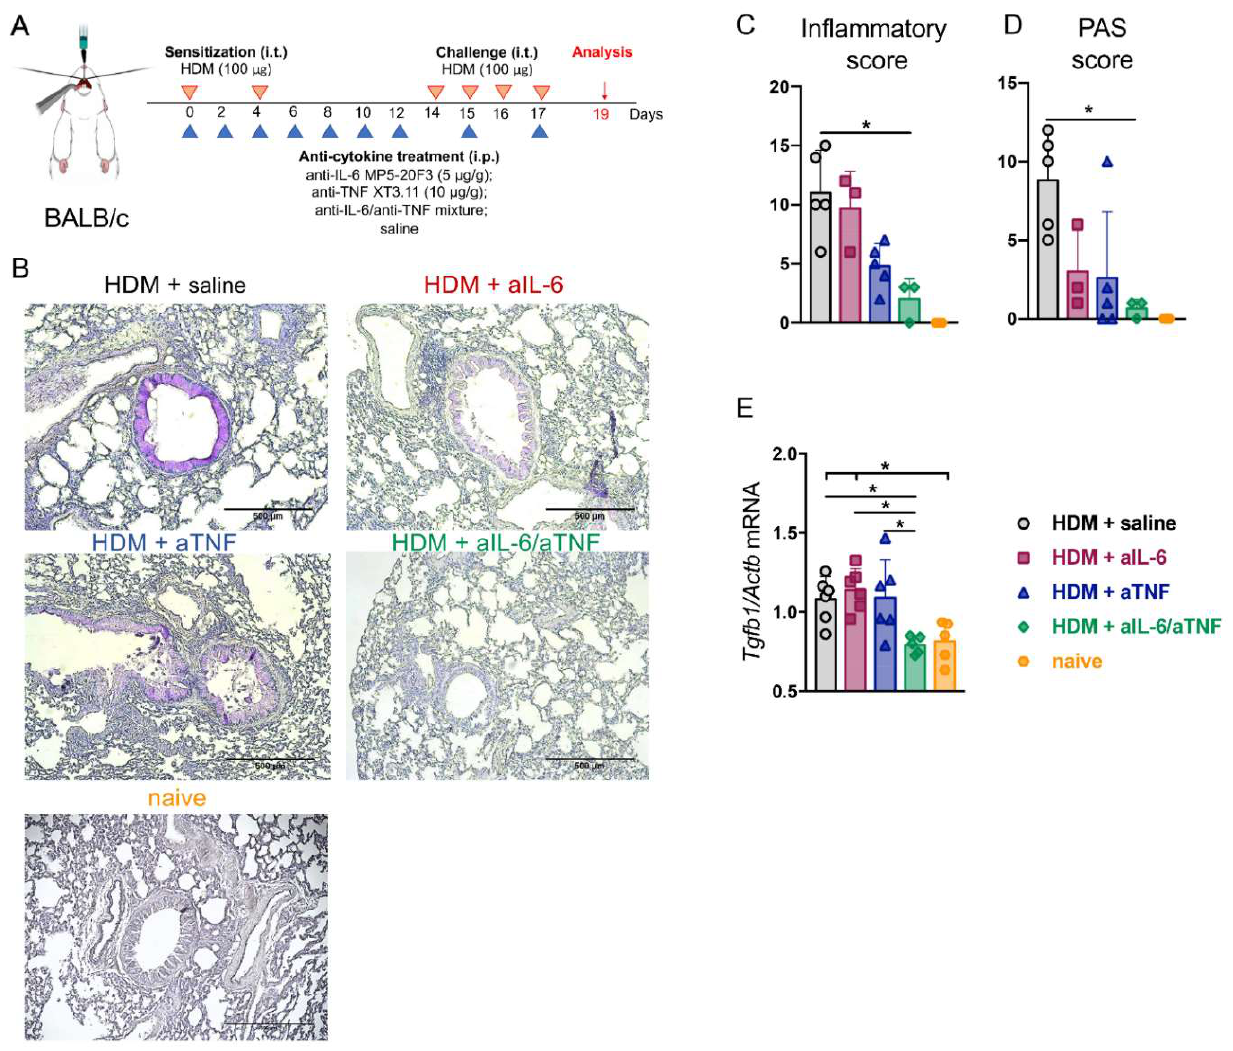
Figure 4. Assessment of lung histology in mice with severe HDM-induced asthma undergoing combined administration of IL-6 and TNF inhibitors. Simultaneous pharmacological inhibition of TNF and IL-6 led to diminished lung tissue remodeling in severe HDM-induced asthma. ( A ) Scheme of severe asthma model; 6–8-week-old BALB/c mice were sensitized i.t. with HDM extract on days 0 and 4 (100 µ g) (red arrows). On days 14–17, mice were challenged i.t. with HDM (100 µ g) (red arrows). Prior to i.t. administration of the allergen, mice were anesthetized by i.p. injection of the Zoletil/Xyla cocktail for anesthesia. Anti-IL-6 (MP5-20F3) (5 µ g/g of body weight), anti-TNF (XT3.11) (10 µ g/g of body weight) antibodies, and saline as a control were administered intraperitoneally prior to each immunization every 48 h for 17 days (blue arrows); 48 h after the last challenge lungs were perfused by cardiac puncture using 0.9% NaCl and fixed in 4% PFA for further histological assessment of lung tissue. ( B ) Representative PAS-stained lung tissue sections (original magnification: 50 × , scale bar: 500 µ m) in control mice with saline and mice injected with anti-TNF and/or anti-IL-6 antibodies (i.p.). ( C ) Lung inflammation and ( D ) PAS-positive cell score. ( E ) Relative expression of Tgfb1 gene normalized to Actb by quantitative RT-PCR analysis in the lungs 48 h after last HDM challenge. Data represent mean ± SD, 5–6 mice per group. * p < 0.05 (one-way ANOVA test was